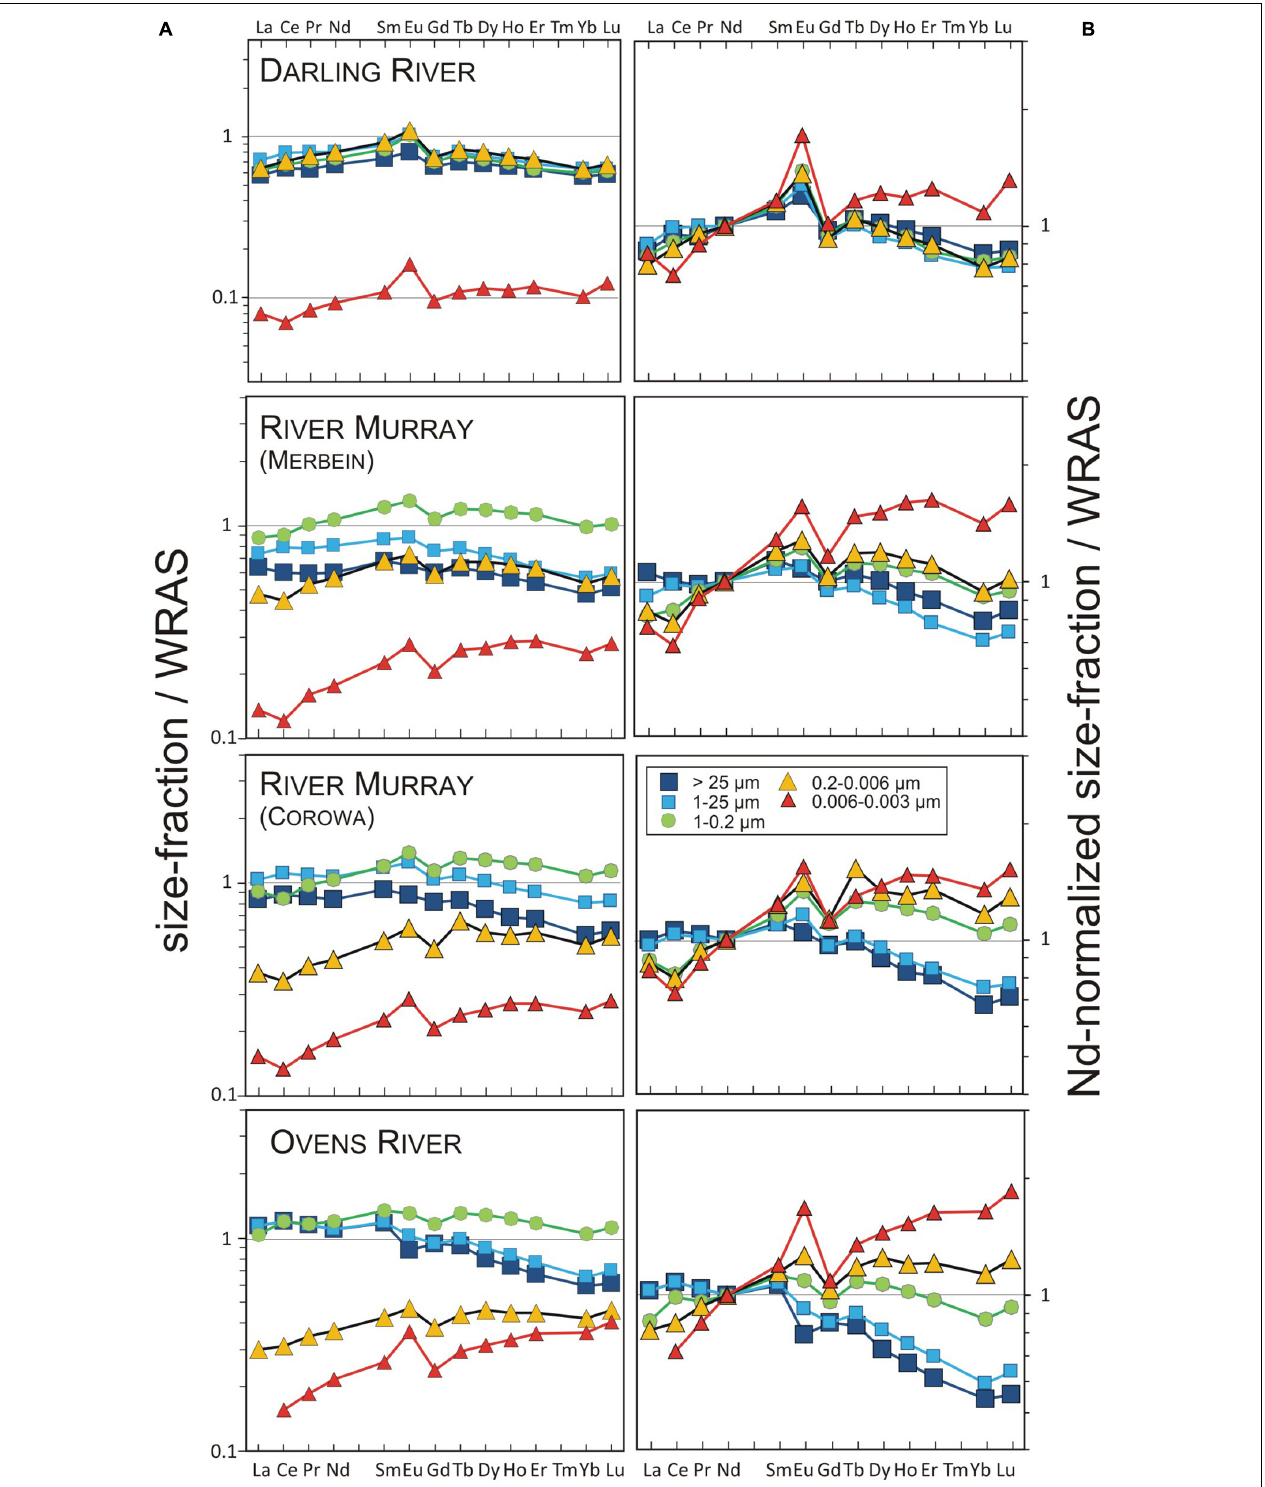
FIGURE 2 | (A) Rare earth element abundances of size-fractions from river suspended material in the Murray-Darlin Basin (Douglas, 1993; Douglas et al., 1999) normalized to World River Average Silt (WRAS; Bayon et al., 2015). (B) WRAS-normalized REE abundances normalized to the Nd WRAS . The different size-fractions analyzed correspond to coarse silts ( > 25 µ m; dark blue squares), fine silts (25–1 µ m; light blue squares), clays (1–0.2 µ m; green circles), coarse colloids (0.2–0.006 µ m; orange triangles), and fine colloids (0.006–0.003 µ m; red triangles).